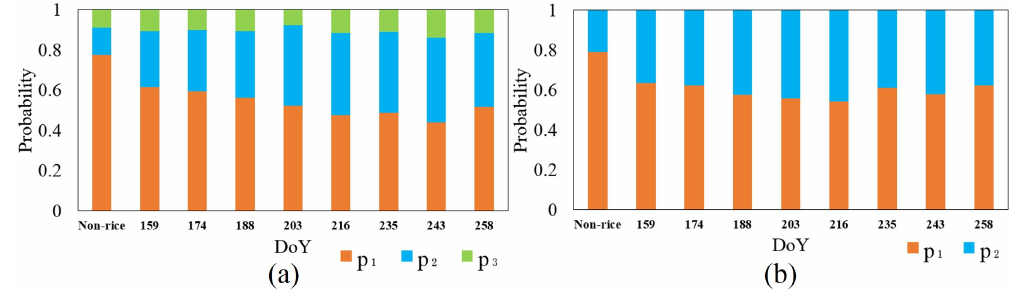
Figure 8. Scattering probabilities for the FCP and DCP modes. ( a ) FCP mode; ( b ) DCP